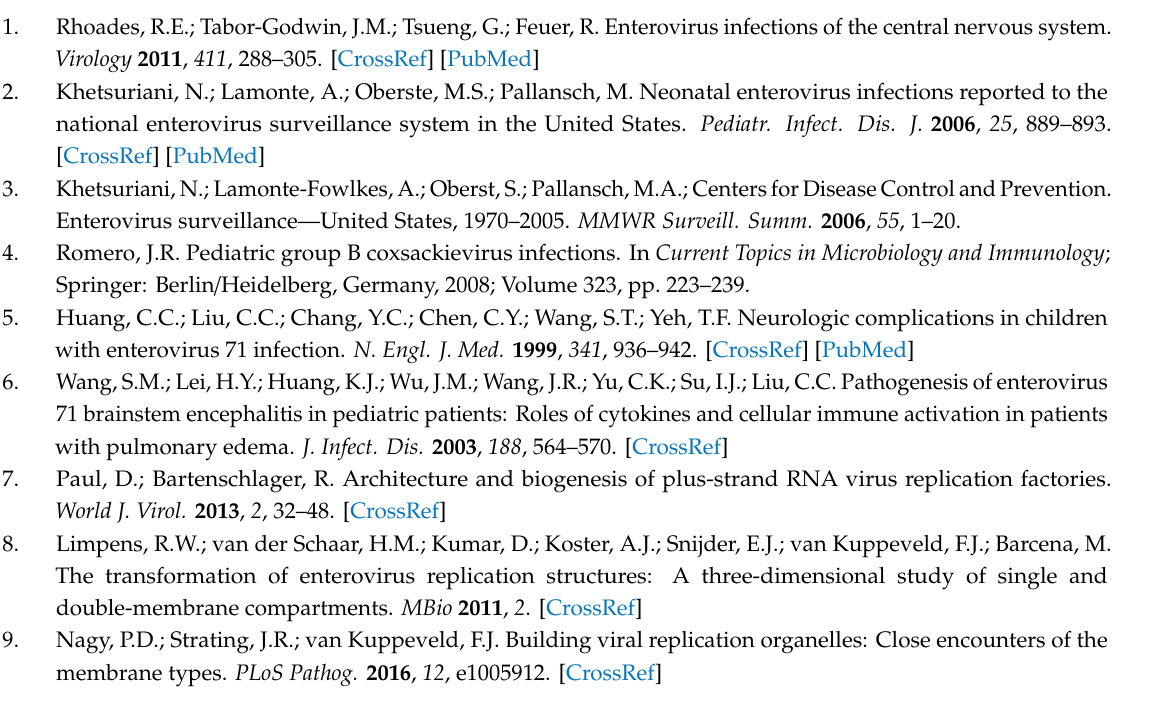
Table S1: Primer and oligonucleotide sequences, Video S1: Real-time imaging of CVB infected RepER expressing cells, Video S2: Real-time imaging of an individual CVB infected RepER expressing cell, Video S3: Real-time imaging of DMSO treated RepOr cells, Video S4: Real-time imaging of RepOr cells treated with brefeldin A, Video S5: Real-time imaging of RepOr cells infected with CVB, Video S6: Real-time imaging of DMSO treated RepOr cell monolayer, Video S7: Real-time imaging of an individual DMSO treated RepOr cell, Video S8: Real-time imaging of 2APB treated RepOr cell monolayer, Video S9: Real-time imaging of an individual 2APB treated RepOr cell. Supplemental File